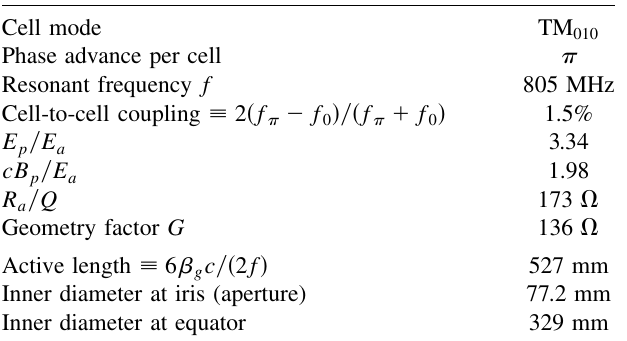
TABLE I. Parameters of the symmetric 6-cell (cid:6) ity. The rf quantities were calculated with SUPERFISH .